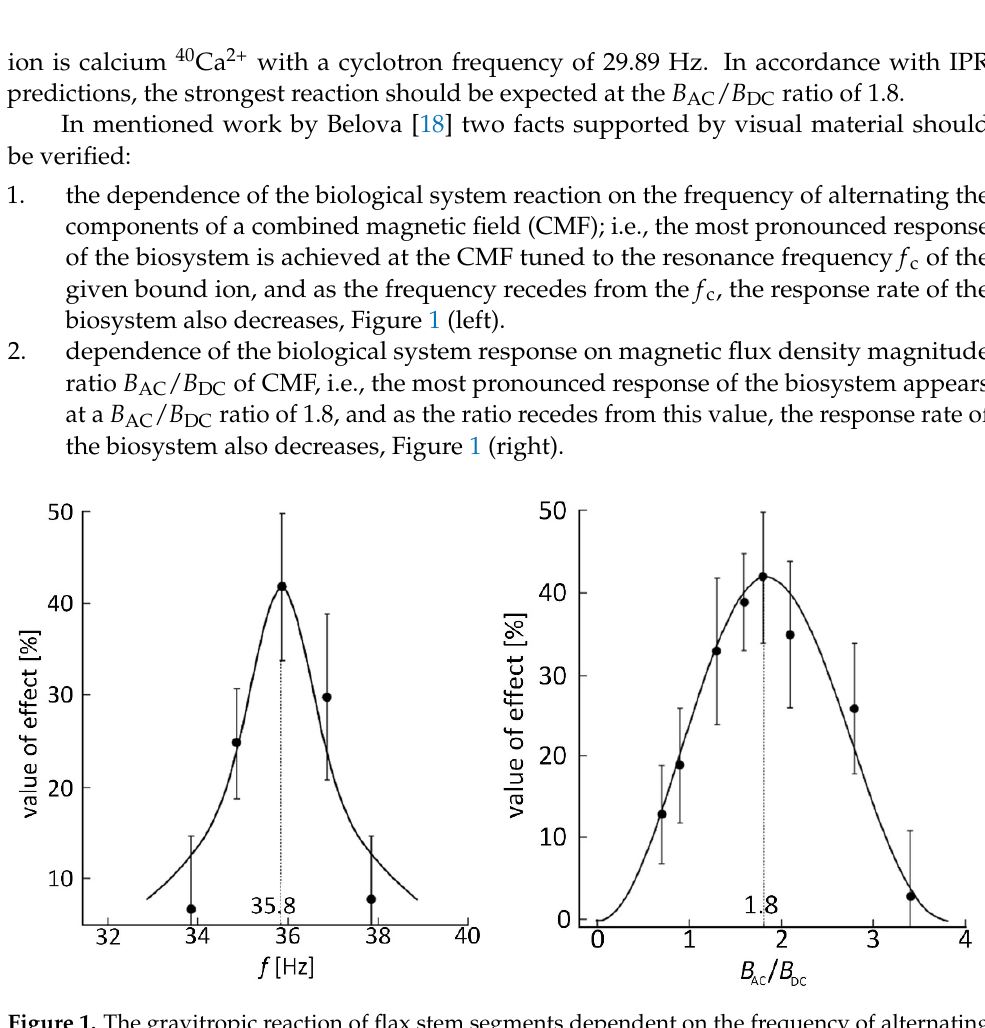
Figure 1. The gravitropic reaction of flax stem segments dependent on the frequency of alternating components of Ca 2+ CMF ( left ) and the magnetic flux density ratio B AC / B DC of Ca 2+ CMF ( right )— adapted from [18].